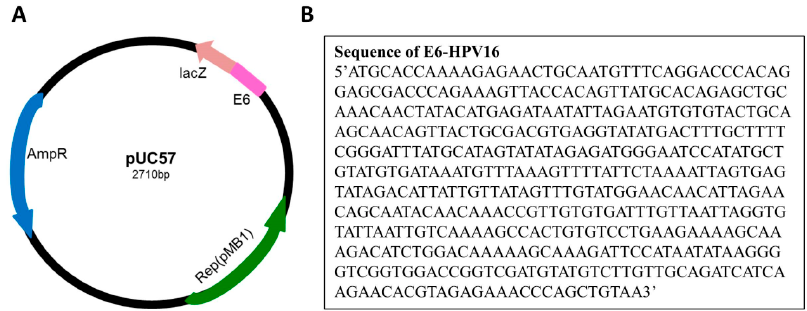
Figure 2. ( A ) Scheme of the pUC-57 vector with cloned E6 gene of HPV16. The construction of human E6-HPV16-pUC57 plasmid was purchased from Genewiz Company (GENEWIZ, South Plainfield, NJ, USA); ( B ) Nucleotide sequence of E6-HPV16 gene.